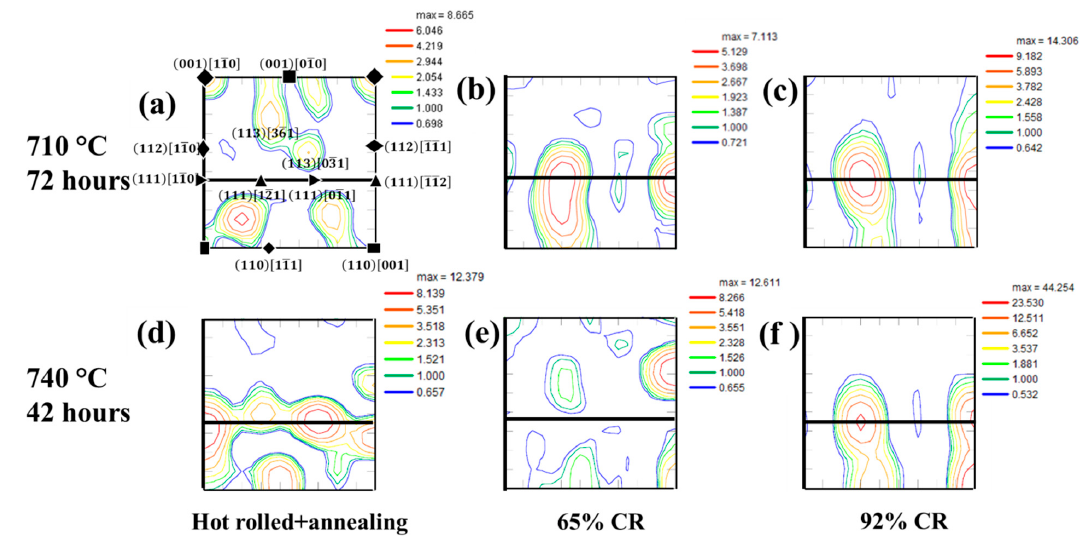
Figure 9. E ff ect of annealing at ( a ) 710 and ( d ) 740 ◦ C prior to cold rolling to 65% ( b,e ) and 92% ( c,f ) Figure 9. Effect of annealing at ( a ) 710 and ( d ) 740 °C prior to cold rolling to 65% ( b,e ) and 92% ( c,f ) reductions in thickness on the ϕ 2 = 45 ◦ sections of the reductions in thickness on the φ 2 = 45° sections of the ODF.